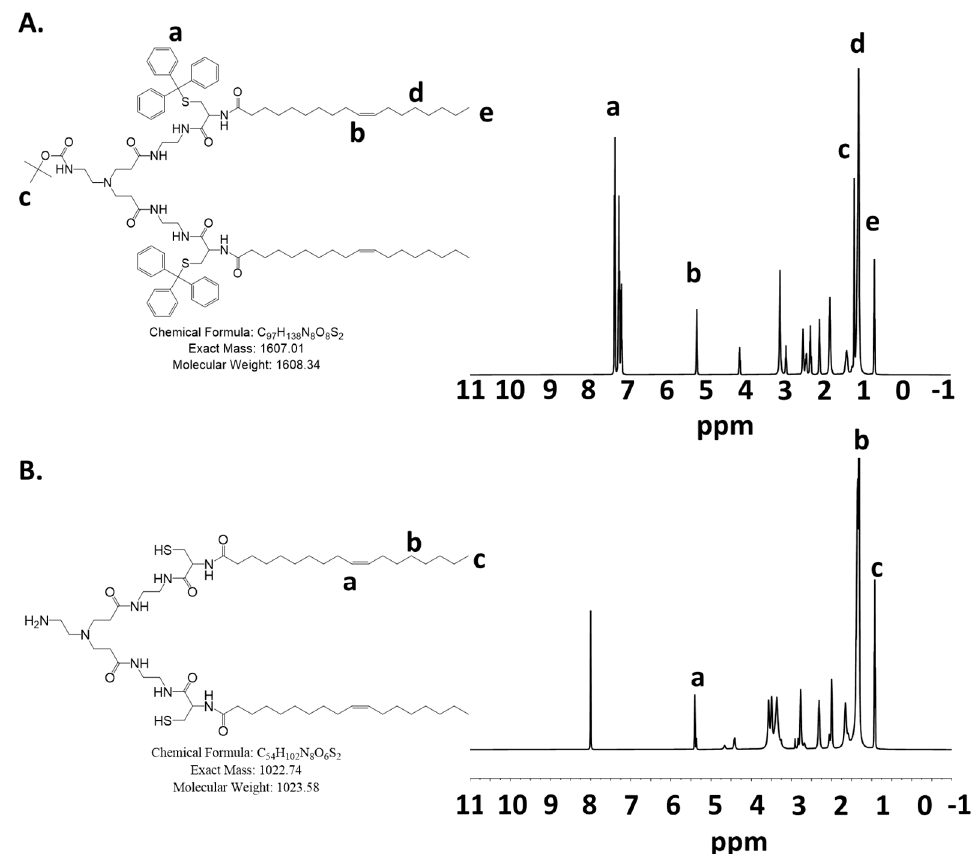
Figure 1. The 1 H − NMR spectra of ( A ) pECO and ( B )